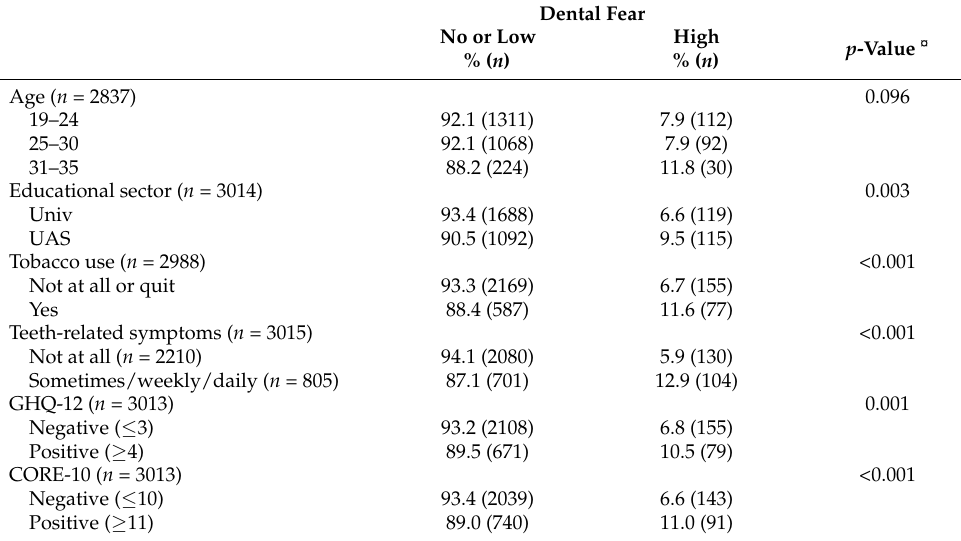
Table 2. Age, educational sector, GHQ-12, CORE-10, perceived teeth-related symptoms, and tobacco use by dental fear ( n = 3013) among the Finnish university students.